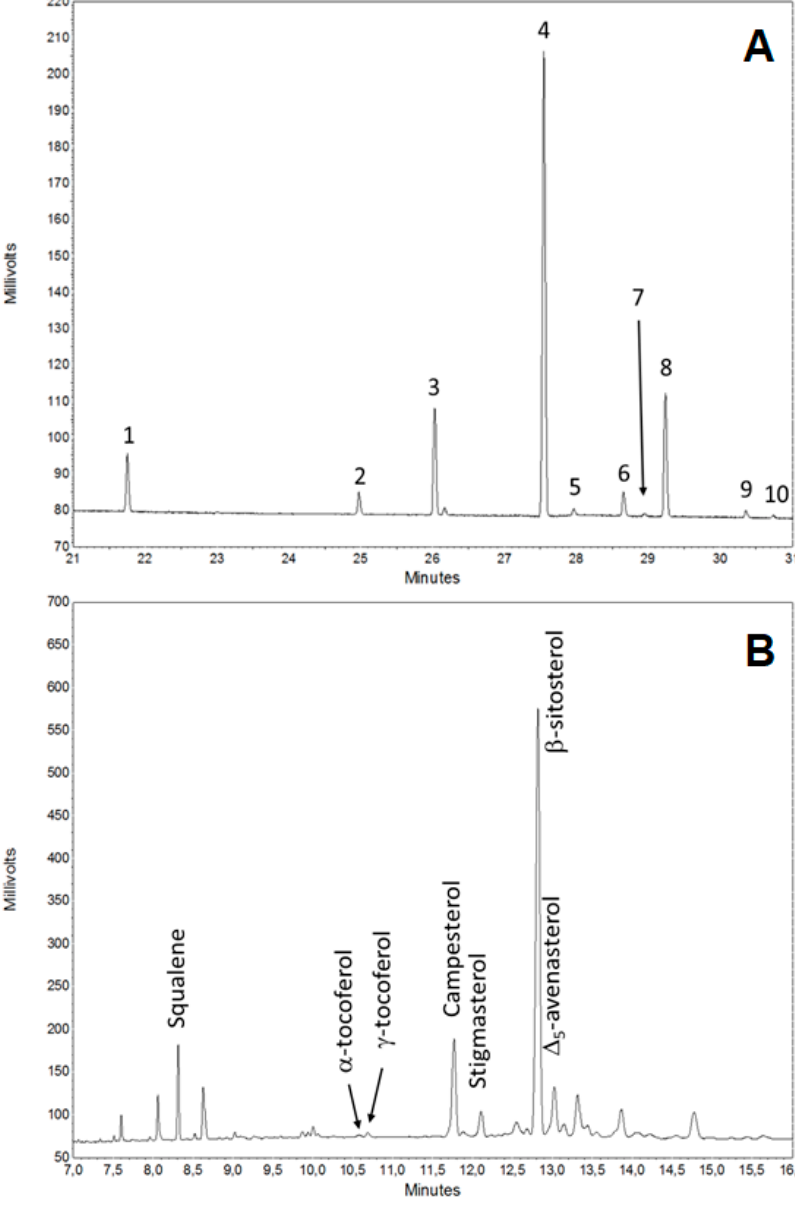
Figure 3. Gas-chromatograms (GC/FID) of hemp ( Fedora cv) oil fatty acids as fatty acid methyl ester (FAME) ( A ) and of the unsaponifiable fraction ( B ). Fatty acid components are assigned in Table 2. Table 2. Composition of fatty acids and unsaponifiable components in lipid extracts from hemp edible products ( Fedora cv).